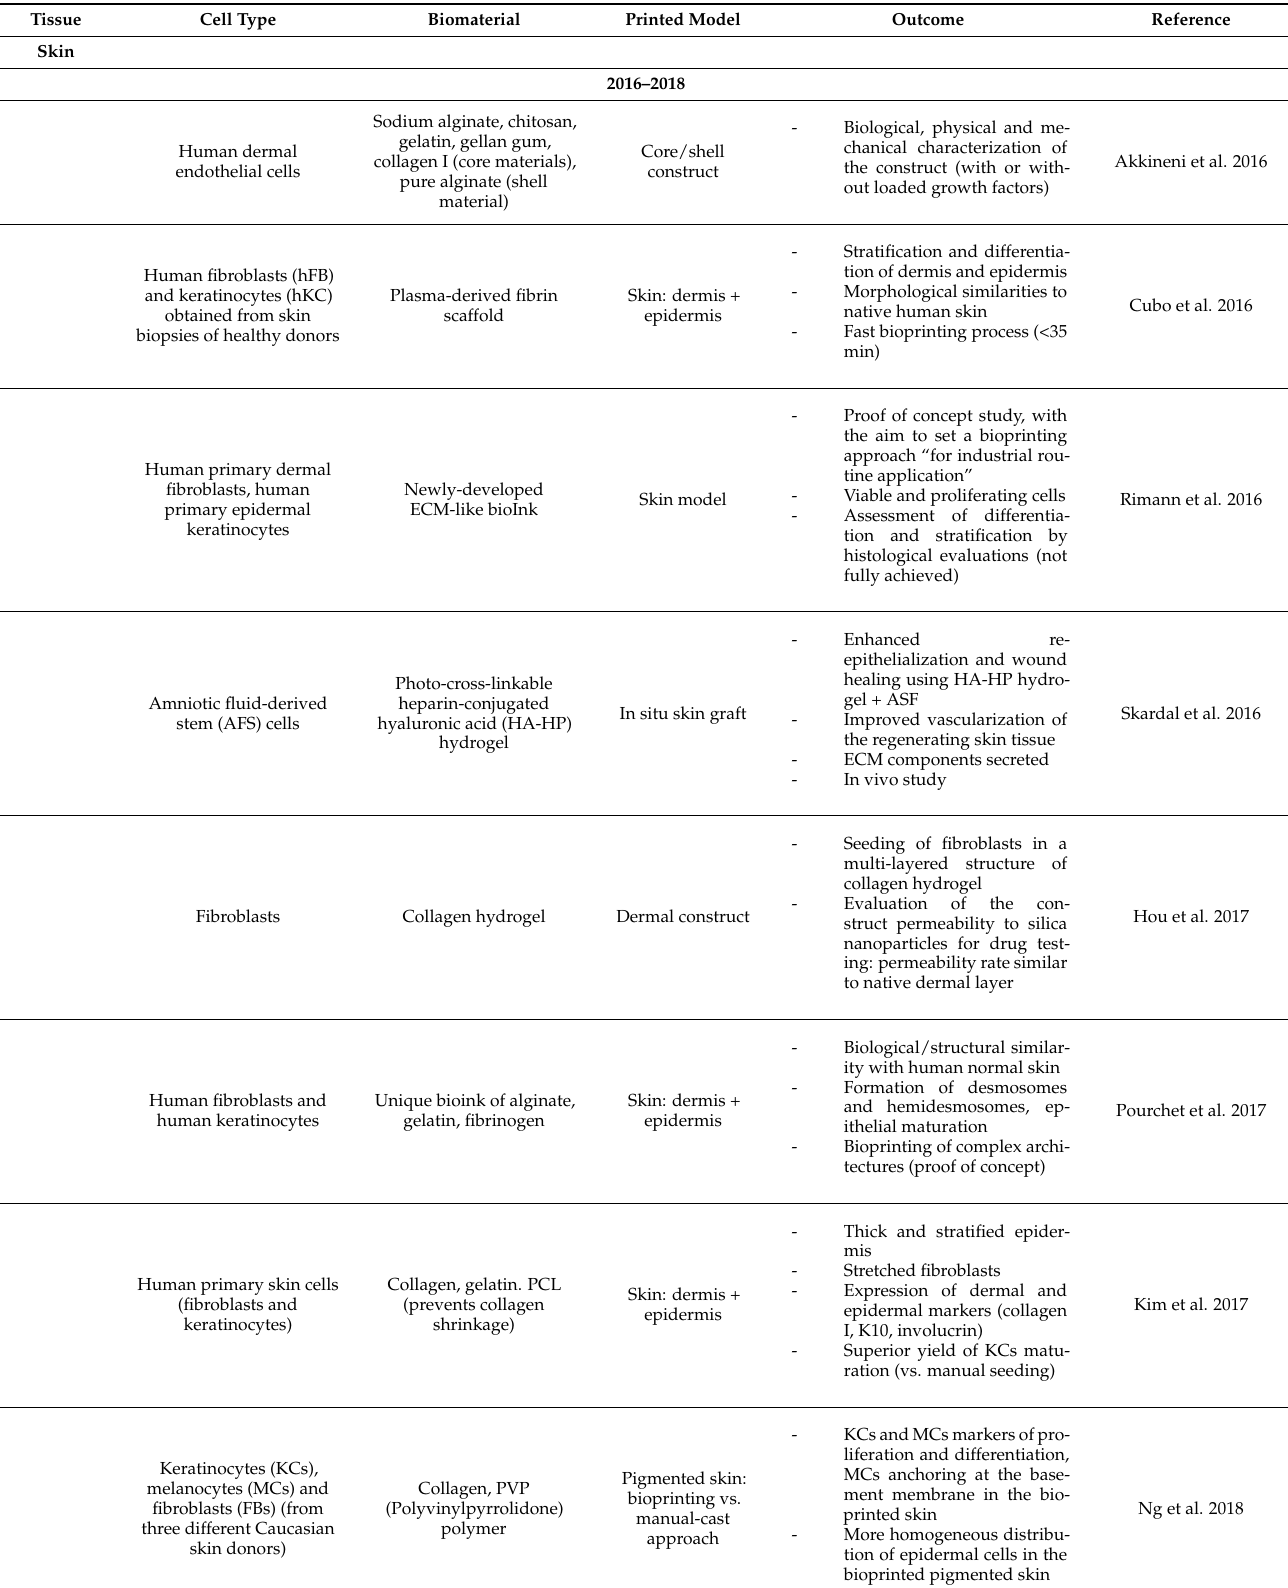
Table 1. Remarkable achievements in 3D bioprinting of skin tissue. Articles from 2016 to 2018 and from 2019 to 2020.